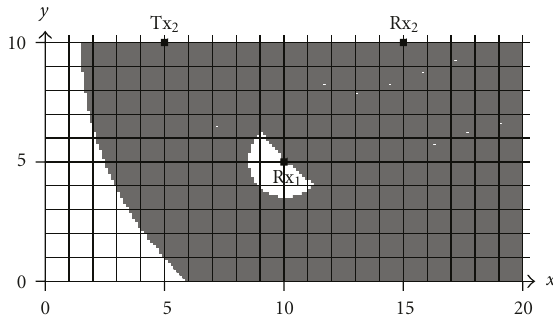
Figure 8: I (2,1) : Influence of the position of Tx 1 on connectivity between Tx 2 and Rx 2 in the sense of Property 3.